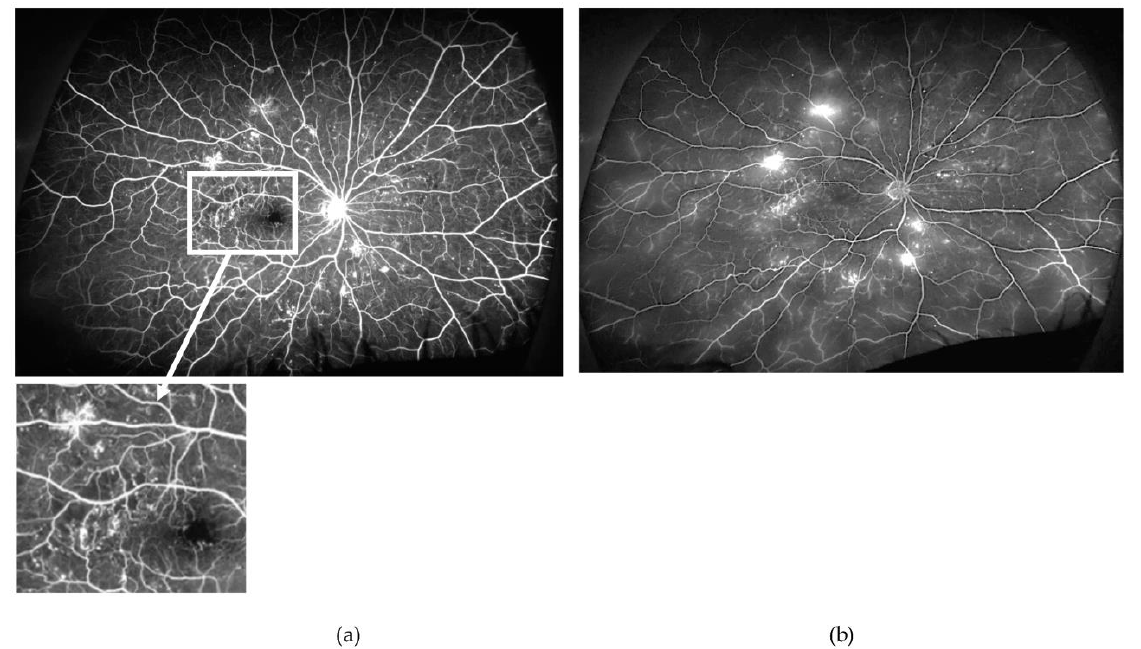
Figure 2. Arterio-venous ( a ) and late ( b ) phases of the ultra-wide field fundus fluorescein angiogram obtained from the right eye of a patient with proliferative diabetic retinopathy (PDR). Note the relatively well-perfused retina, except for very small areas of retinal ischaemia (example in inset) but several mid-peripheral new vessels elsewhere. Findings are very suggestive that other mechanisms, besides retinal ischaemia (e.g., inflammation), contribute to new vessel formation. Furthermore, findings highlight the great variability on the extension of areas of retinal ischaemia required for the occurrence of PDR.